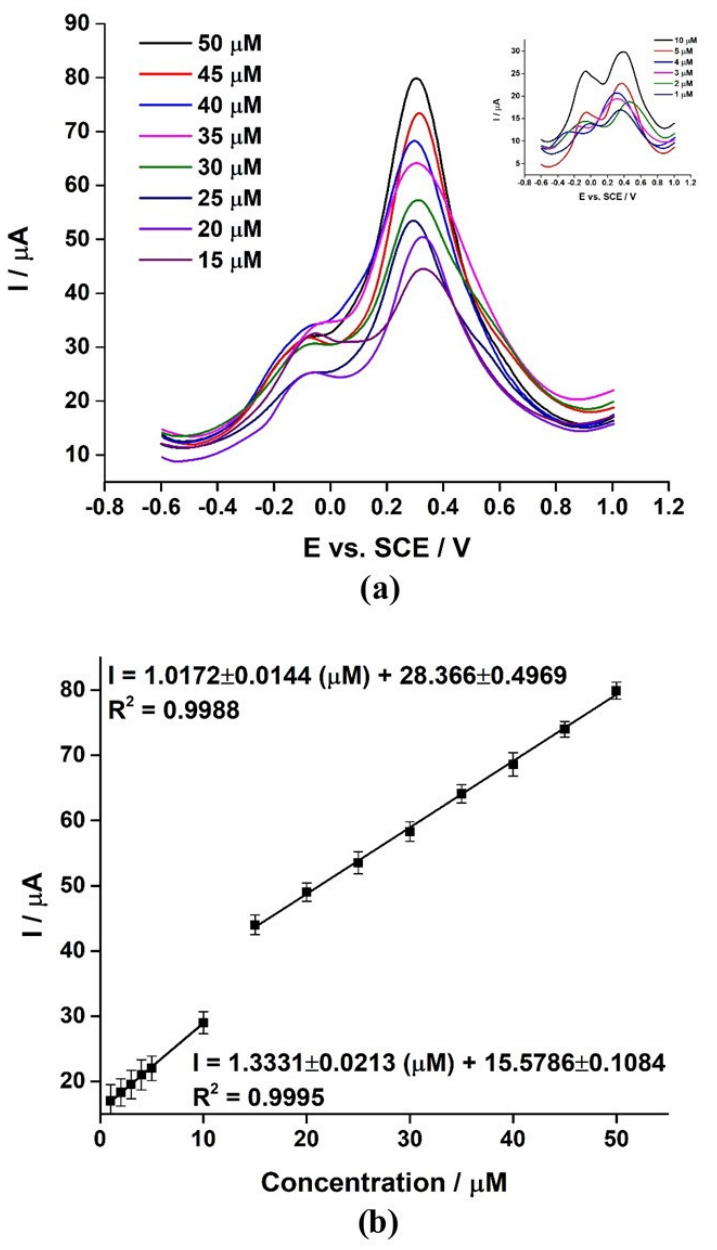
Figure 8. ( a ) SWV curves of GA@PAni-CNT in two different concentration ranges of NO 3 − and corresponding ( b ) linear relationships. Table 1. Comparison of the analytical features of GA@PAni-CNT electrode with some of the reported works.